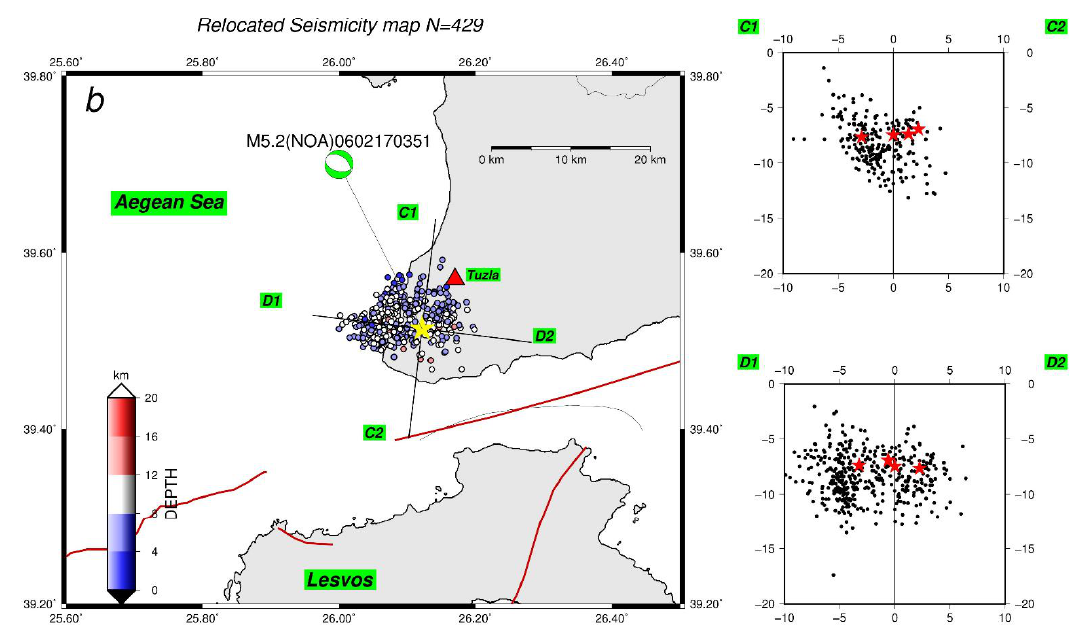
Figure 6. Map of Biga Peninsula area—Aegean Sea, showing distribution of catalogue ( a , b ) relocated epicenters (1st February–28 February 2017). The town of Tuzla is indicated by a red triangle. Cross sections A1–A2 and C1–C2 are oriented N193 ◦ E, B1–B2 and D1–D2 N103 ◦ E, respectively. All sections are 10 km swaths along the central trace and 20 km long. Catalogue data are NOA solutions published at http://bbnet.gein.noa.gr except for the main events (yellow stars) that use the Table 1 locations. Relocated events are from this study. A south-dipping plane can be seen on the vertical cross section C1-C2 that shows the foci projections orthogonal to fault’s strike.